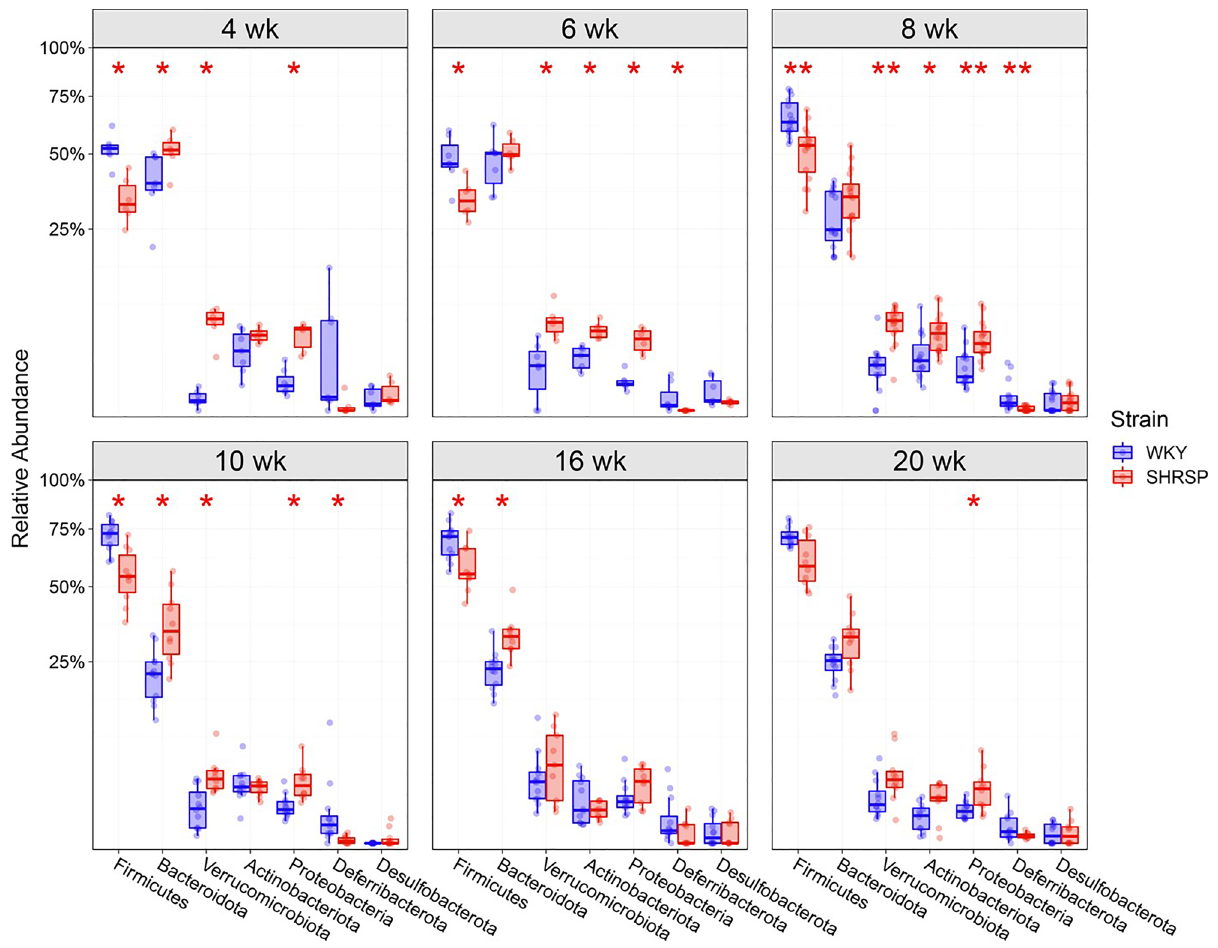
Figure 3. Relative abundance of phyla in SHRSP and WKY at 4, 6, 8, 10, 16 and 20 weeks (n = 6–15). * and ** p < 0.05 and 0.01 respectively compared to WKY at the same age using Mann–Whitney U test with FDR corrected for multiple